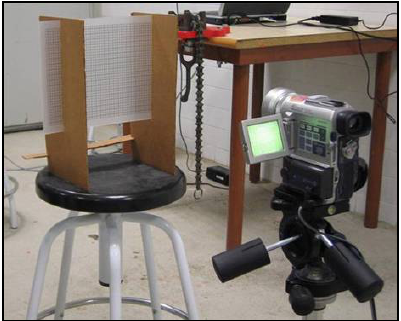
Figure 3. Plastic translucent grid template and digital camera used in characterisation of the laser